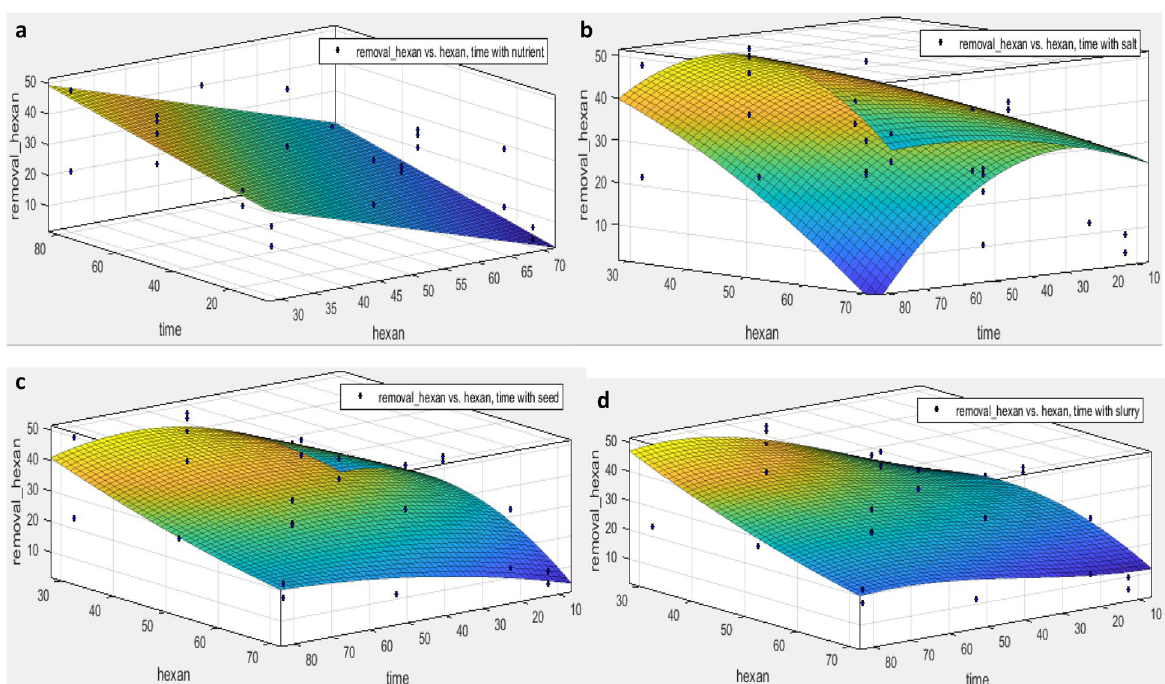
Figure 5. The effect of exposure time and initial hexane concentration on hexane removal perxent. ( a ) the presence of nutrient, ( b ) the presence of microbial salt, ( c ) the presence of seed and d) the presence of slurry, by excel version 2013